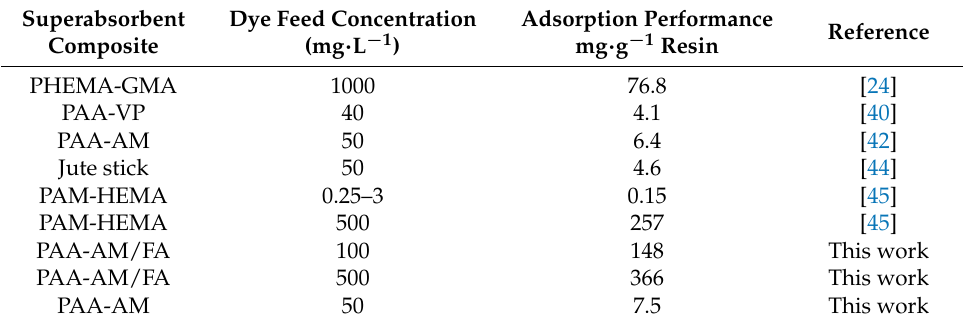
Table 7. The adsorption to Rhodamine B by different superabsorbent